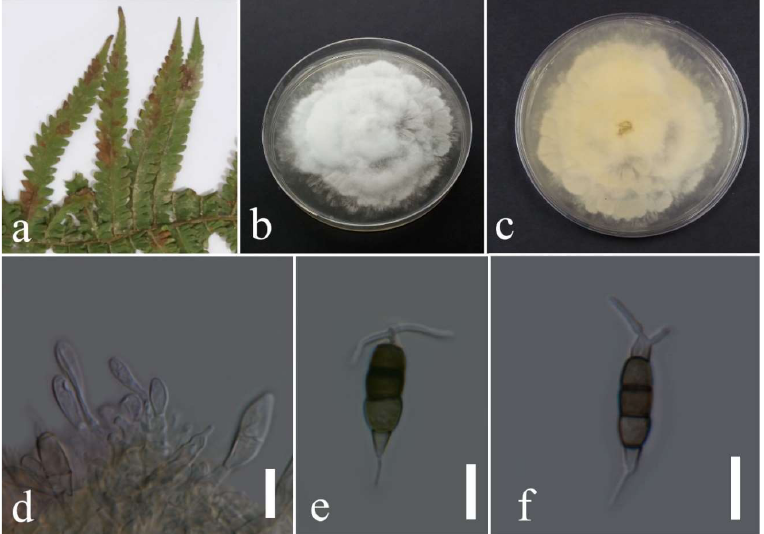
Figure 10. Morphology of Neopestalotiopsis phangngaensis (MFLUCC 22 - 0157): ( a ) brown leaf spot in Cyclosorus sp . ; ( b , c ) upper and reverse views of the colony after seven days of growth on PDA at 28 °C; ( d ) conidiogenous cells; ( e , f ) conidia . Scale bars = 10 µm . Neopestalotiopsis psidii I . U . Haq, Ijaz & N . A . Khan, 2021. Facesoffungi number: FoF 13404; Figure 11. Associated with Nephrolepis cordifolia leaf spot. Sexual morph : not observed . Asexual